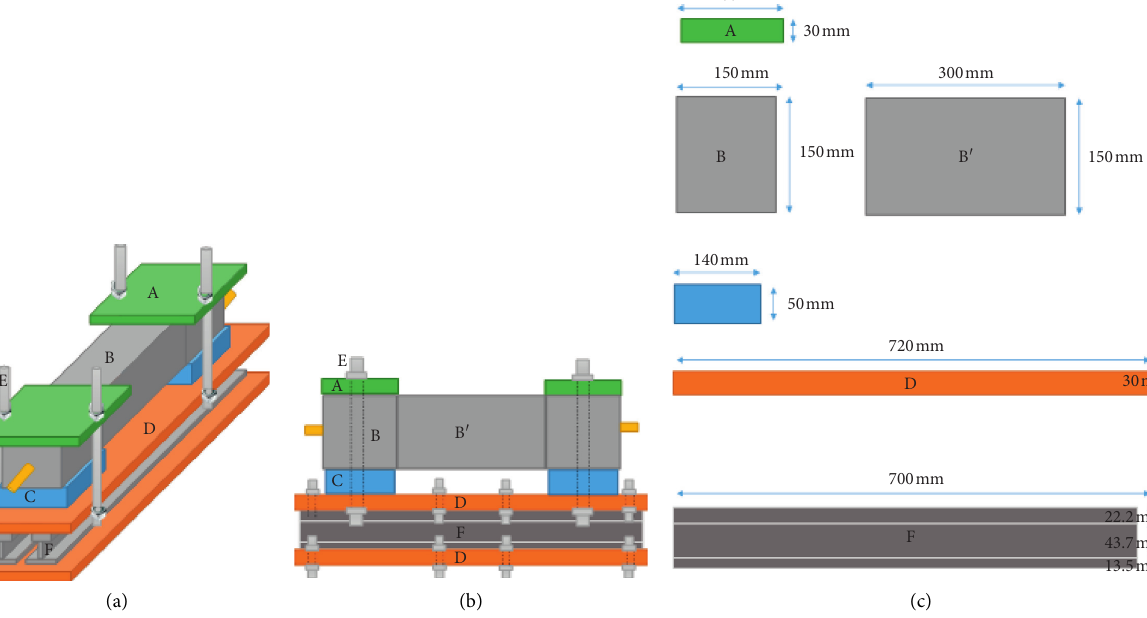
Figure 2: Double shear test apparatus: (a) isometric view; (b) sectional view; (c)